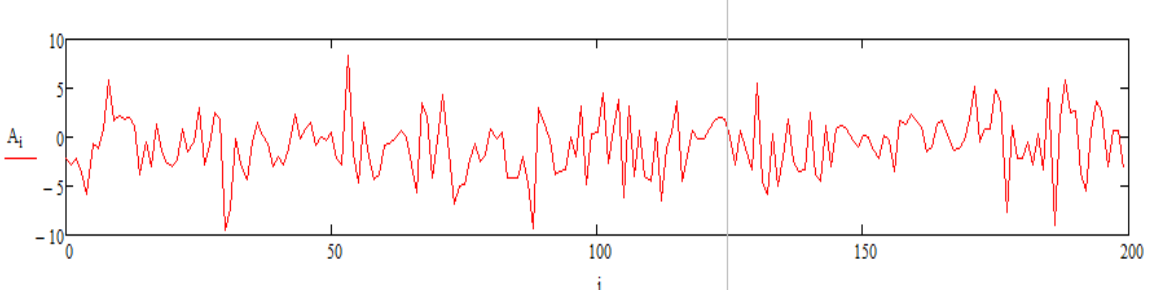
Fig. 7. Graph modelling a random function of a parameter in flight without failures.